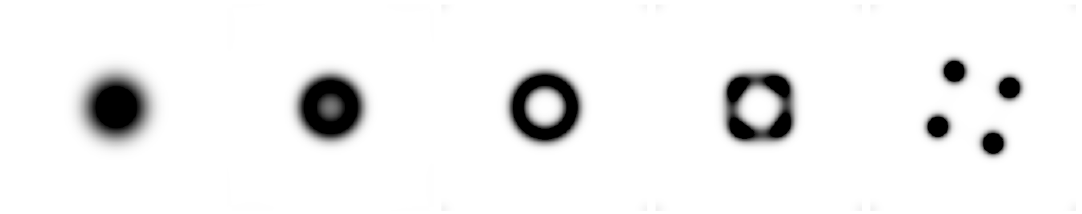
Figure 11 . Snapshots of time evolution of a ring-like axisymmetric perturbation of the MP black hole with a = 3. The eventual breakdown of axial symmetry is triggered by any generic perturba- tion, such as numerical noise.